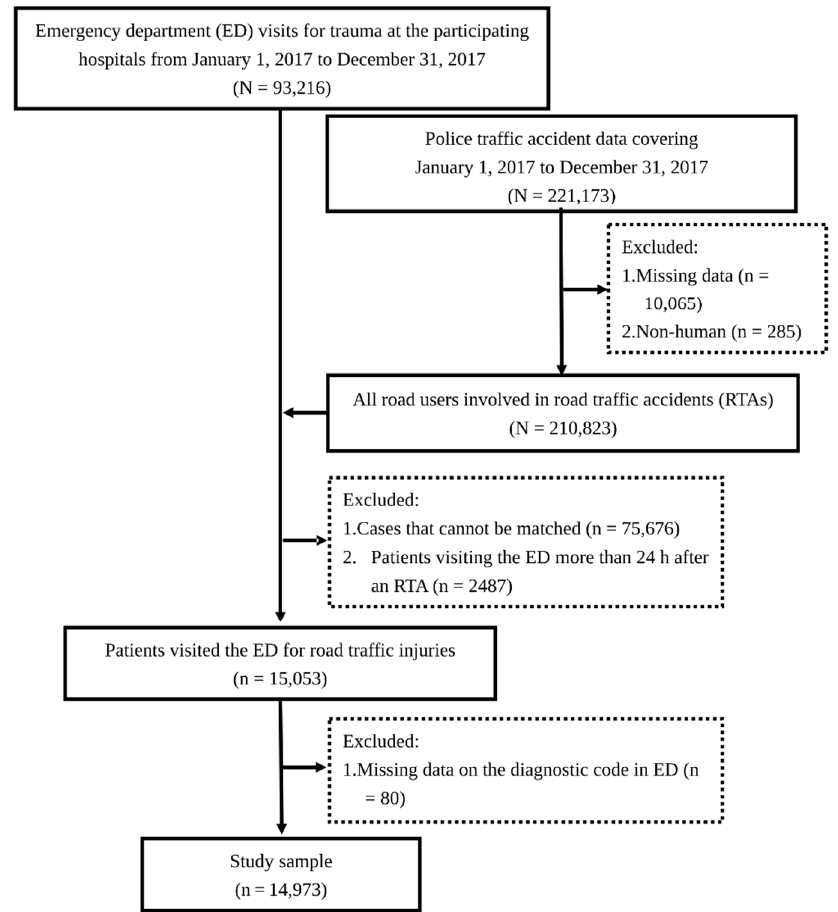
Figure 2. Flow chart showing the sample selection process. ED, emergency department; RTA, road traffic accident.